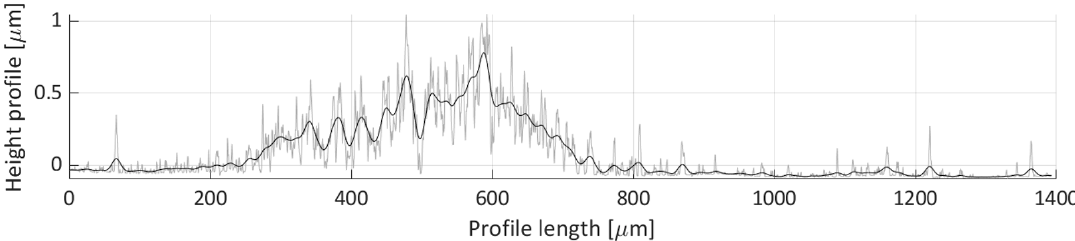
Figure 22. Height profile for the H2 line.